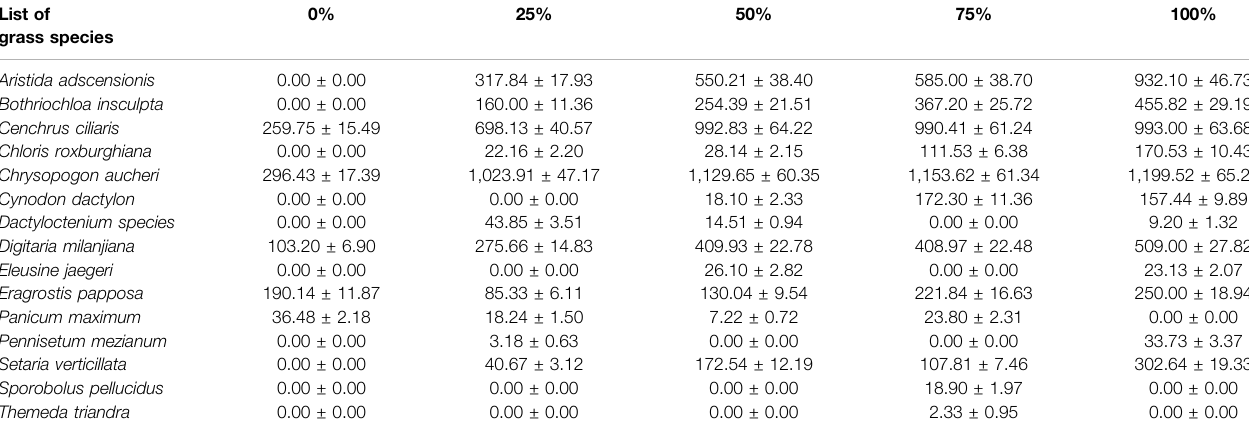
NB: % (cid:2) treatment plot.